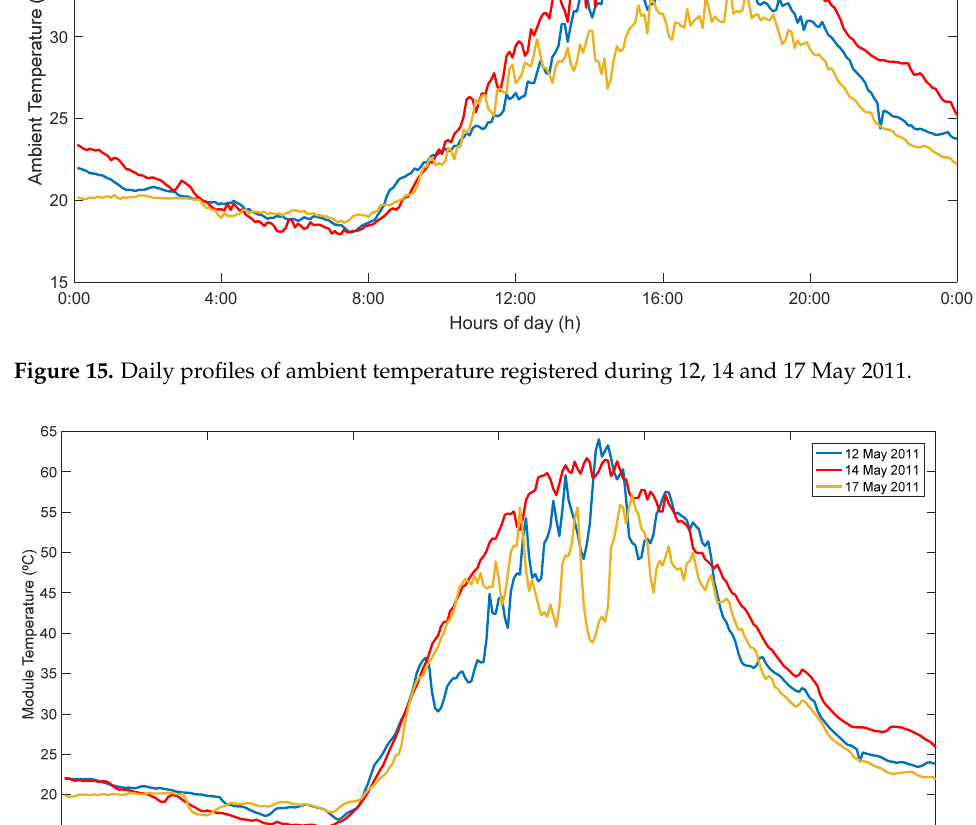
Figure 16. Daily profiles of module temperature registered during 12, 14 and 17 May 2011.